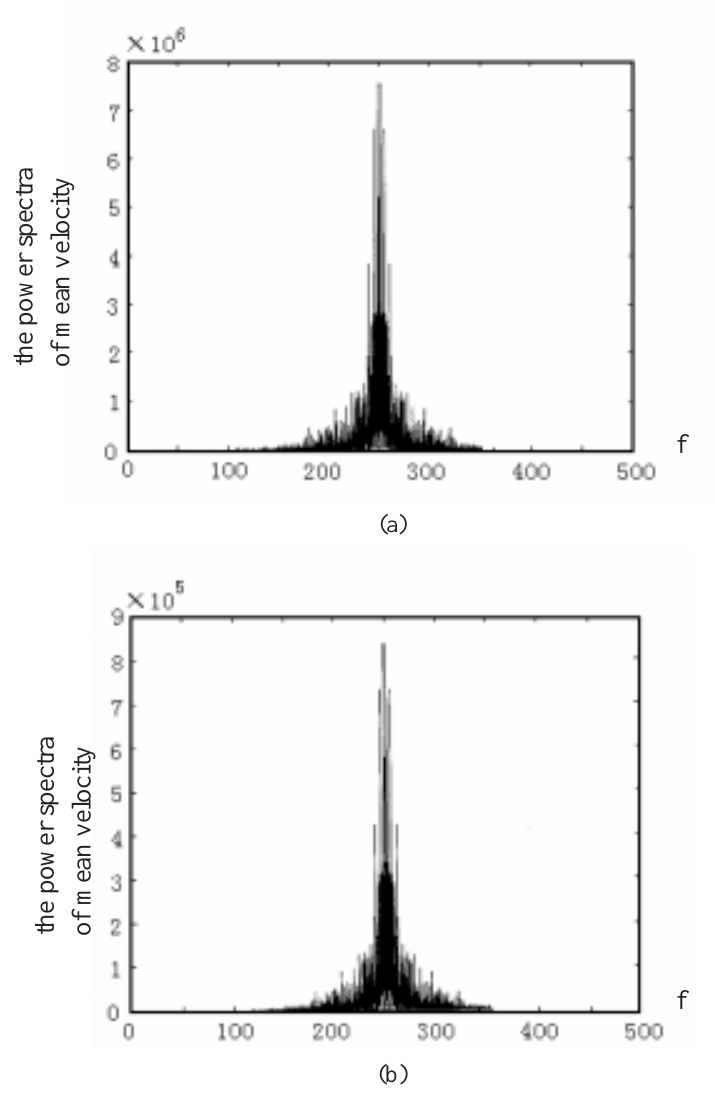
Fig. 3. the power spectra of mean velocity, f